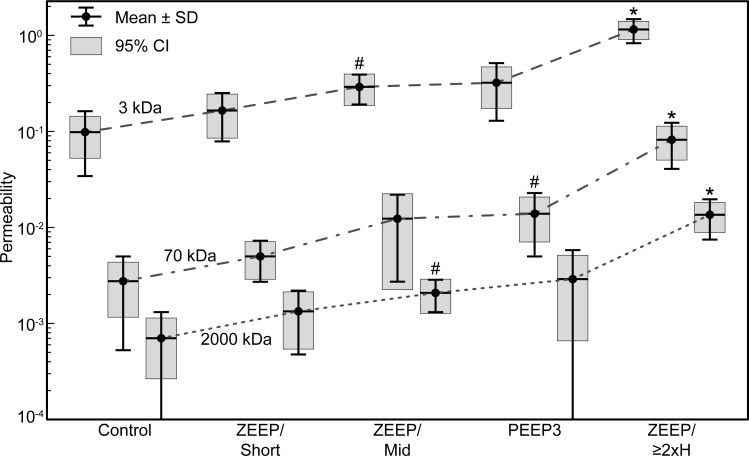
Blood-gas barrier permeability by ventilation group and dextran conjugate size.Permeability is defined as the ratio of bronchoalveolar lavage fluid fluorescence to serum fluorescence for each size of dextran conjugate (3 kDa, 70 kDa, and 2000 kDa). *Significant increase in permeability from all other groups within dextran size. #Significant increase from Control (p<0.05). ZEEP: zero end-expiratory pressure, PEEP3: positive end-expiratory pressure = 3 cmH2O, Short: ventilation time 30 min, Mid: ventilation time 60 min, ≥2xH: ventilation until elastance (H) at least doubled.